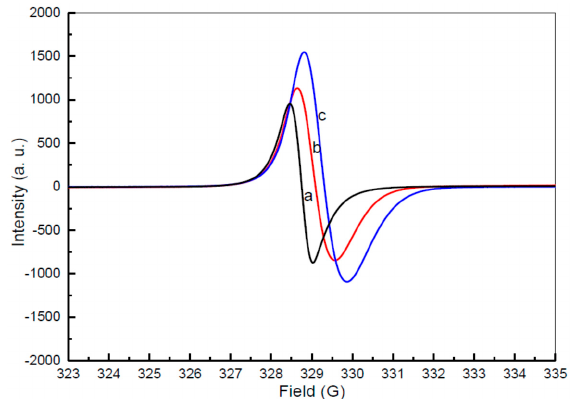
Figure 8. ESR spectra of CdO nanoparticles at different concentration of PVP ( a ) 0.03, ( b ) 0.04, and ( c ) 0.05 g/mL. Table 2. Magnetic parameters of CdO nanoparticles observed for ESR analysis. PVP (g/mL) (cid:1859) ‐